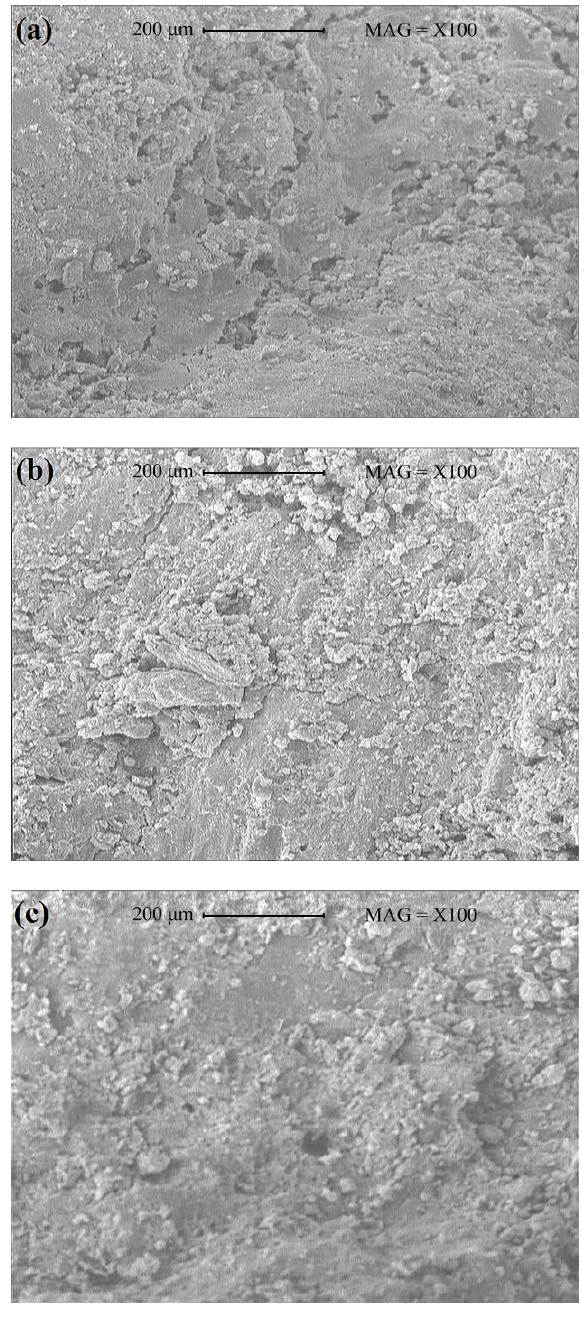
Figure 11. SEM images (100×) of concrete mixes with ( a ) regular tap water; ( b ) magnetized water after passing 10 times; and ( c ) magnetized water after passing 80 times through a permanent magnetic field at a constant speed of 2.25 m/s.